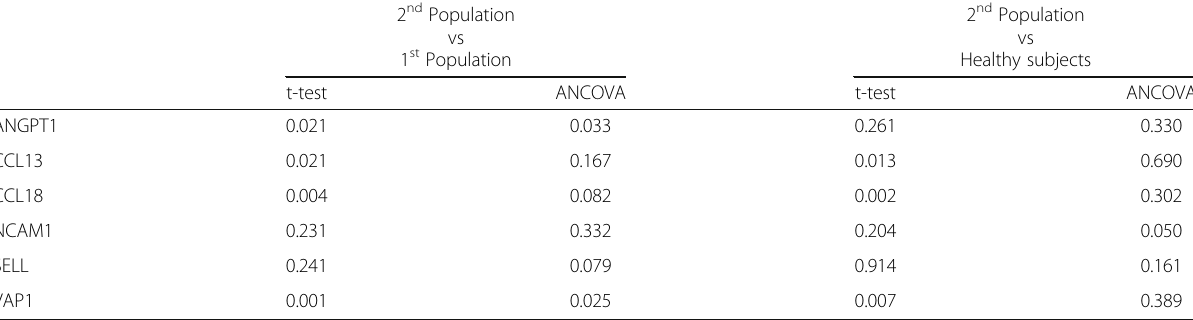
Table 4 Comparison of protein plasma levels in MS patients (1st and 2nd populations) and healthy subjects